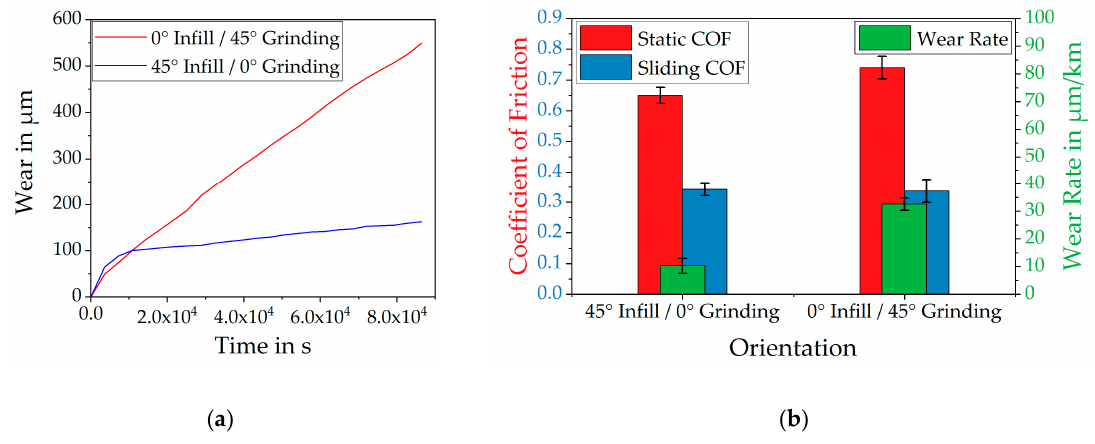
Figure 7. Wear ( a ) as well as wear rate and friction coefficients ( b ) of two tribo-contacts with different